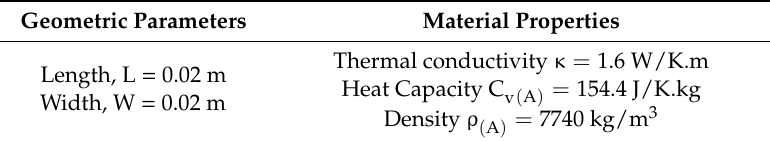
Figure 12. Edge crack (a) geometric parameters and boundary condition. Table 7. Geometric Parameters and Material Properties.